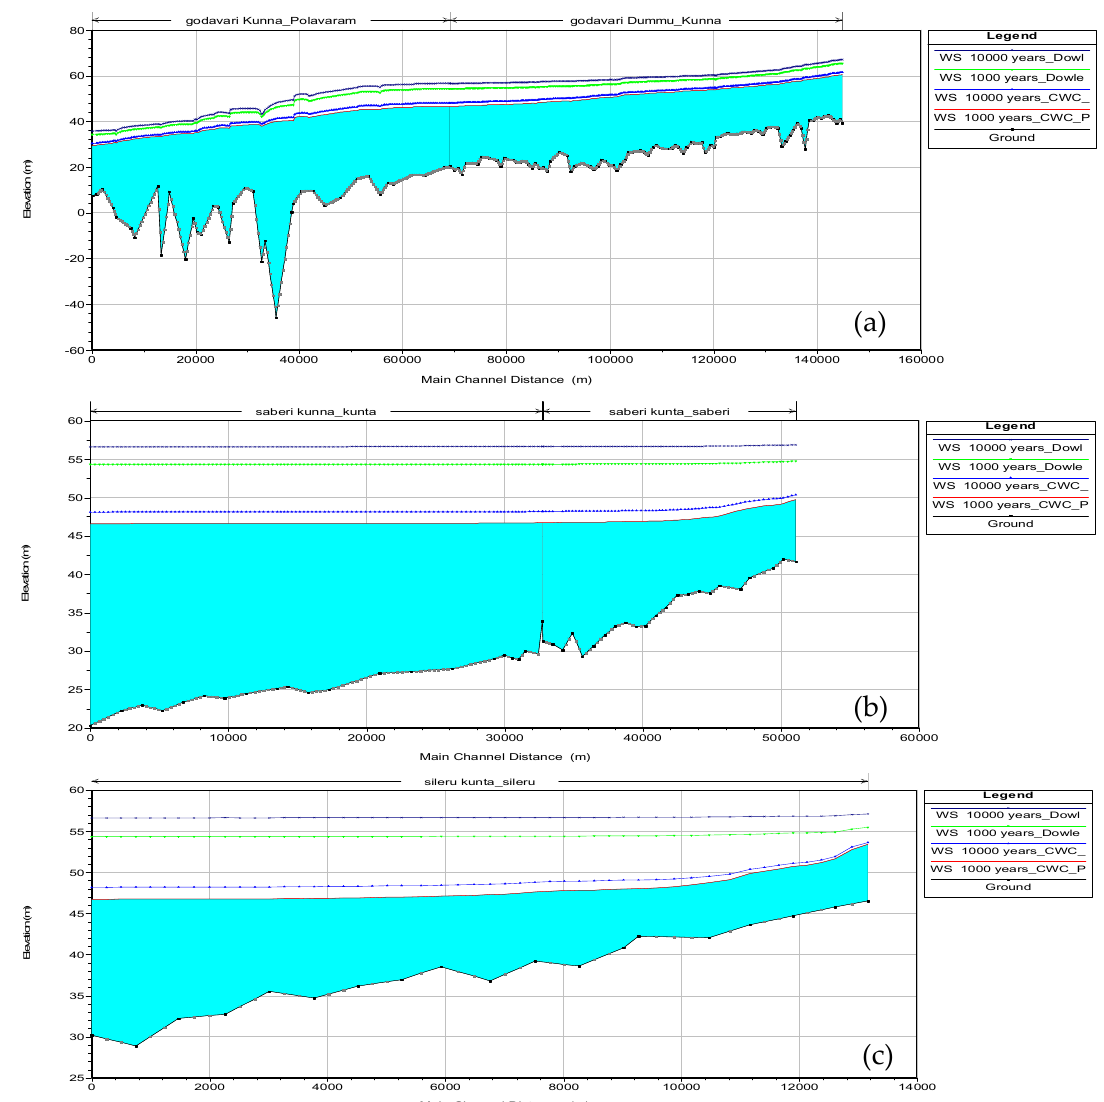
Figure 9. Water surface elevation for 1000 and 10,000 years discharge considering Polavaram and Dowleswaram data from ( a ) Polavaram to Dummugudem ( b ) Kunnavaraam to Saberi along river Saberi and ( c ) Konta to Sileru. Table 8. Water surface levels at Bhadrachalam with and without dam for different discharges under 2D unsteady state conditions.